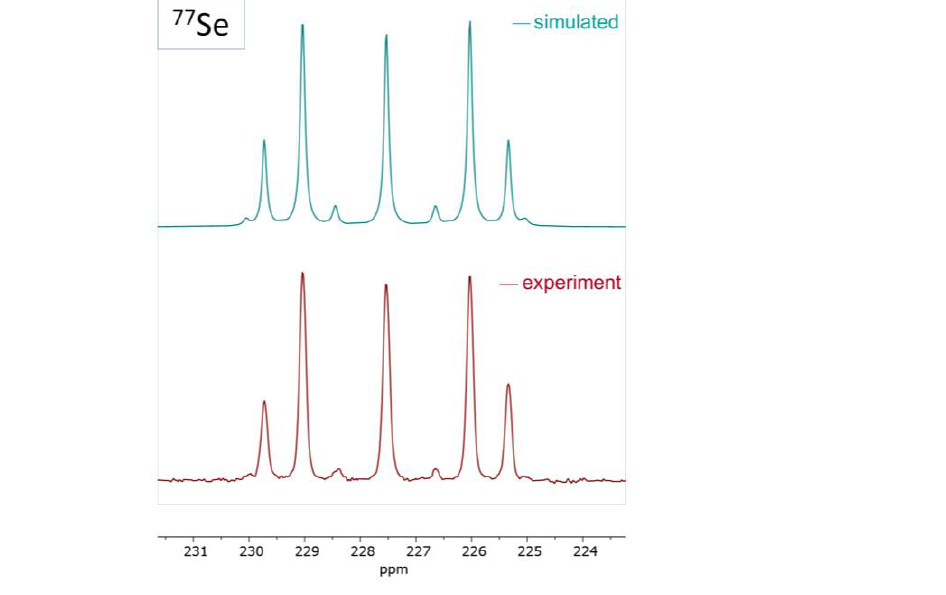
Figure 4. Measured ( top ) and simulated ( bottom ) 77 Se-NMR spectrum of silver(I) complex 6 (MeCN- d 3, 300 K). The following coupling constants were used for the simulation: 1 J PSe = 286 Hz, 2 J PP = 152 Hz, 1 J 1 J 3 J 2 J 2 J PSe = 0 Hz, P-(107)Ag = 401 Hz, P-(109)Ag = 462 Hz, Se-(107)Ag = Se-(109)Ag = 0 Hz. The coordination of 3b to gold(I) changed the 31 P NMR shift to lower field and resulted in two singlet signals at 85.9 and 85.2 ppm in 7 with selenium satellites ( 1 J SeP = 329 Hz and 1 J SeP = 332 Hz, respectively). 77 Se NMR spectra of compound 7 showed a set of two doublets at 271.1 ( 1 J SeP = 329 Hz) and 268.9 ( 1 J SeP = 332 Hz) ppm for the Se atoms of the two different rac and meso diastereomers, which were deshielded compared to 5 and 6 . Copper(I) complex 5 and silver(I) complex 6 crystallized with two molecules in the − asymmetric unit in the triclinic space group P 1, while the gold(I) complex 7 crystallized in the monoclinic space group P 2 1 /c. The X-ray crystal structures of 5 and 6 (Figure 5) revealed a trigonal planar coordination geometry ( 5 : Σ Cu1 = 358.9(1) ◦ and 6 : Σ Ag1 = 357.6(1) ◦ ) at the coinage metal atom with d 10 -metal atoms bonded to two phosphorus units with bite angles between 113.82(2) ◦ in 6 and 115.36(5) ◦ in 5 , which are comparable to those found in related dppf analogs [20–22]. The tilt angle ( α ) of the ferrocene unit showed values of 2.3(2) ◦ ( 5 ) and 2.25(14) ◦ ( 6 ), which is the typical range for phosphorus-rich [3]ferrocenophanes [6,7,11–13,23]. The torsion angle τ increased from 49 ◦ in 5 to 55 ◦ in 6 , which indicated a high distortion of the ferrocene unit. The preferred linear coordination of gold(I) prevented the formation of a gold(I)-bridged [3]ferrocenophane. The resulting dinuclear complex 7 (Figure 6) entailed two Au-Cl units that were almost linear (P1-Au1- Cl1 179.12(4) ◦ and P2-Au2-Cl2 176.83(3) ◦ ) with P-Au distances of 2.2277(90) Å (P1-Au1) to 2.2307(9) Å (P2-Au2). The P-Se bond lengths remained unchanged after coordination to the transition metal centers ( 5 : 2.2556(14) Å, 6 : 2.2523(7) Å, and 7 : 2.2541(10) Å) compared to the free ligand 3b (P1-Se1 2.2595(10)